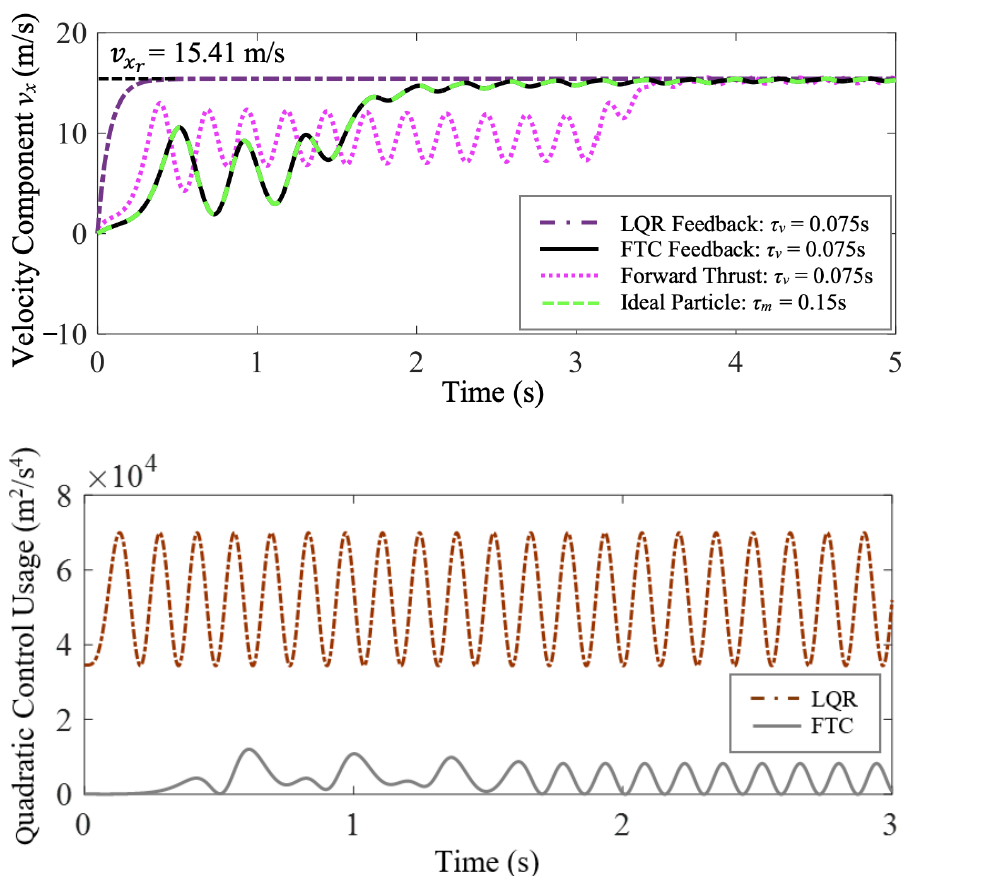
Figure 7. Case study 2: the comparison of the horizontal velocity of the ideal particle and purely thrust-driven, FTC-controlled, and LQR-controlled vehicles and the comparison of the FTC and LQR control cost show that the two controlled vehicles both achieve and maintain the desired horizontal steady-state velocity, but the FTC-controlled vehicle costs much less control